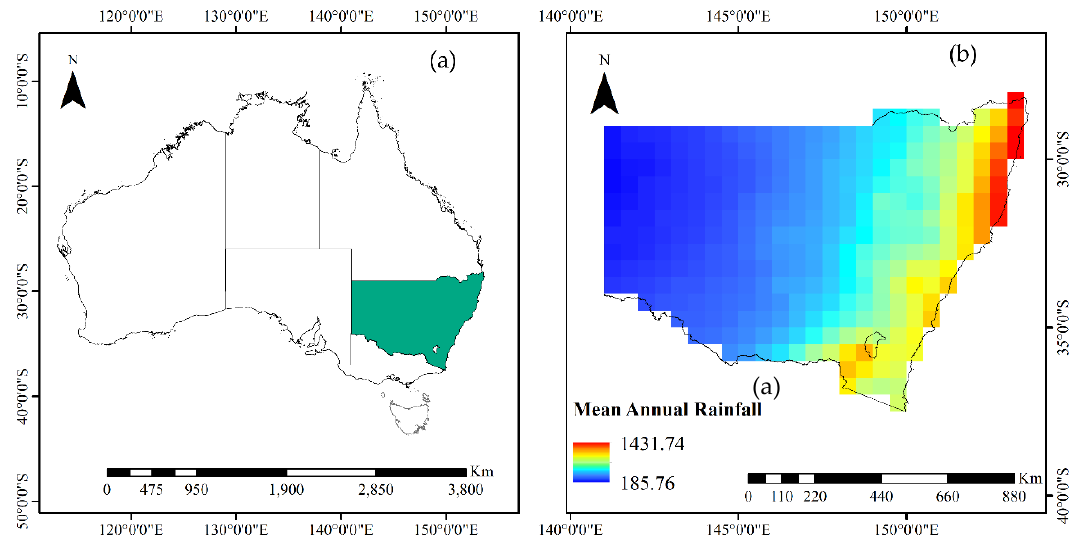
Figure 1. Study area in ( a ) Australia, and ( b ) mean annual rainfall of New South Wales (NSW) (1901–2018), based on Climate Research Unit Time Series (CRU-TS) dataset.